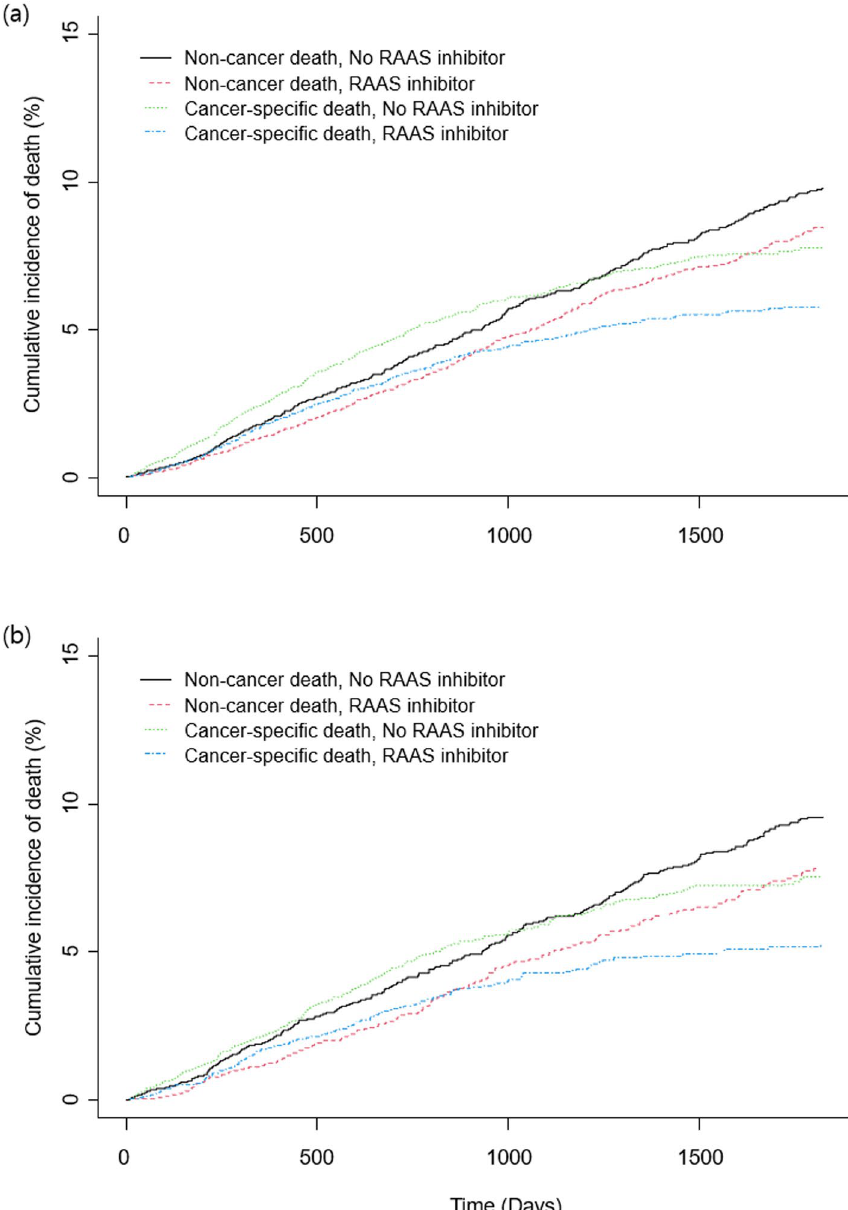
Figure 2. Cumulative incidence of non-cancer and cancer-specific death during 5-years in ( a ) entire and ( b ) matched population. RAAS renin–angiotensin–aldosterone